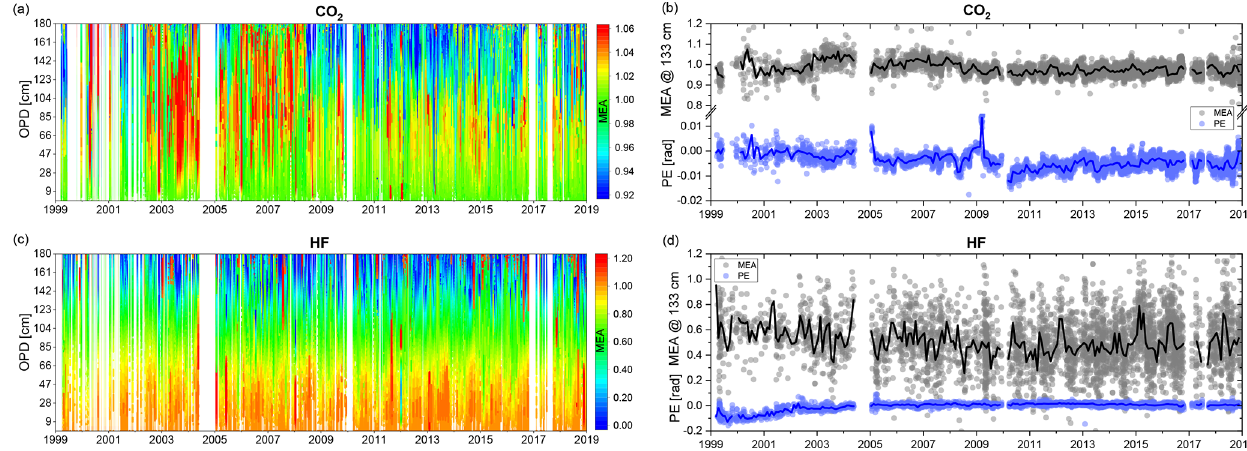
Figure B1. Time series of the MEA as a function of the OPD from 1999 to 2018 evaluated from simultaneous ILS retrievals (a) from CO 2 and (c) from HF absorbing lines. Panels (b) and (d) are the same as (a) and (c) but for the MEA at an OPD of 133cm and including the phase error (PE), which is constant throughout the whole OPD range. Note that the coloured scale for the MEA is different between (a) and (c)